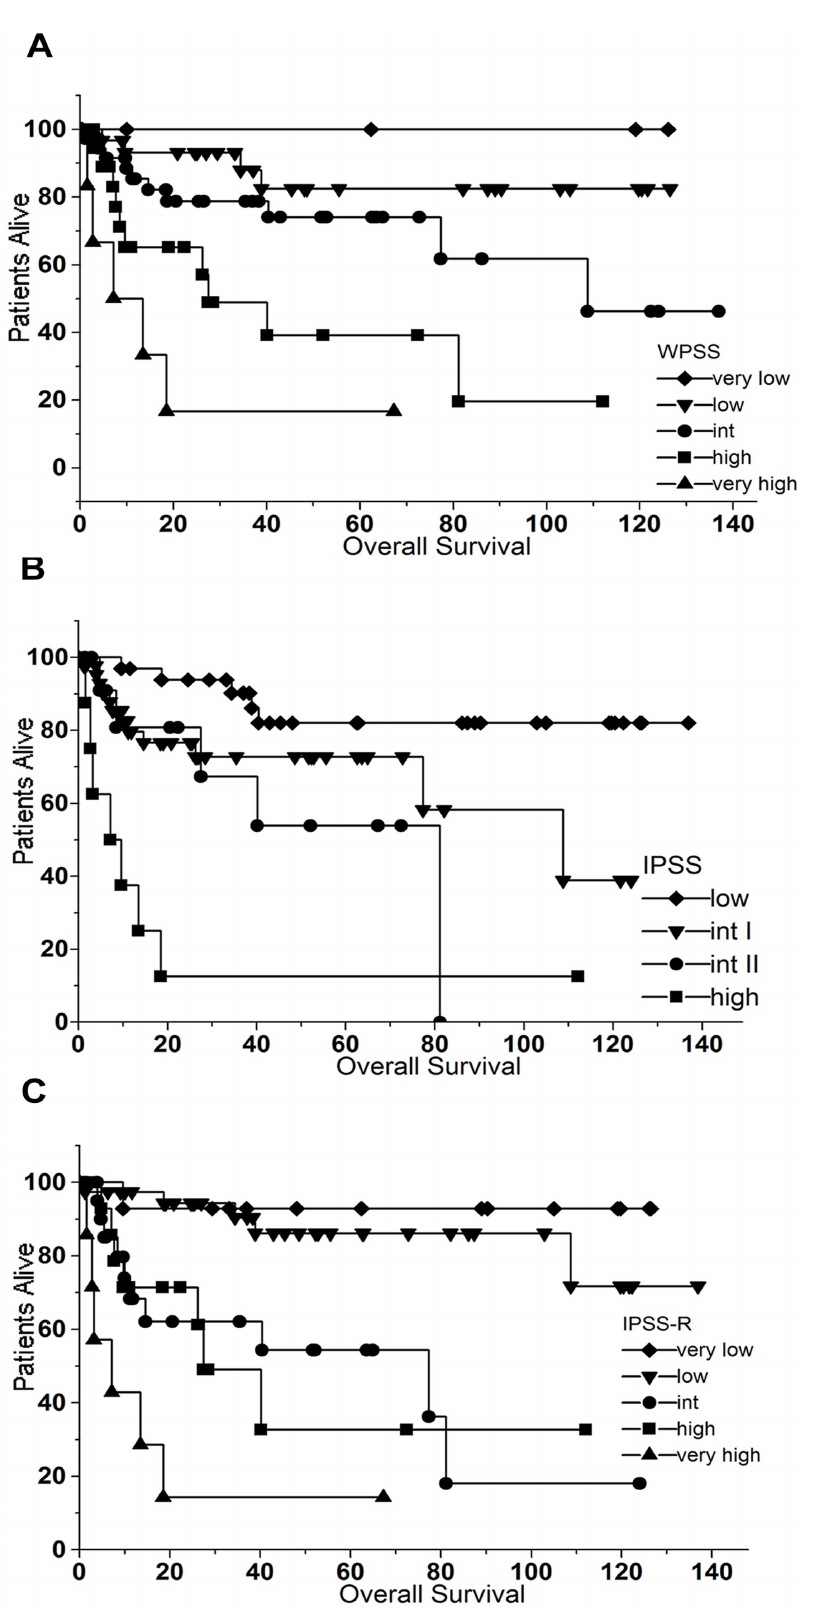
Figure 4. Kaplan-Meier estimates for overall survival of the patients according to WPSS (A), IPSS (B) and IPSS-R (C). All three scores were able to separate patients with a significantly different survival (p , 0.0001).